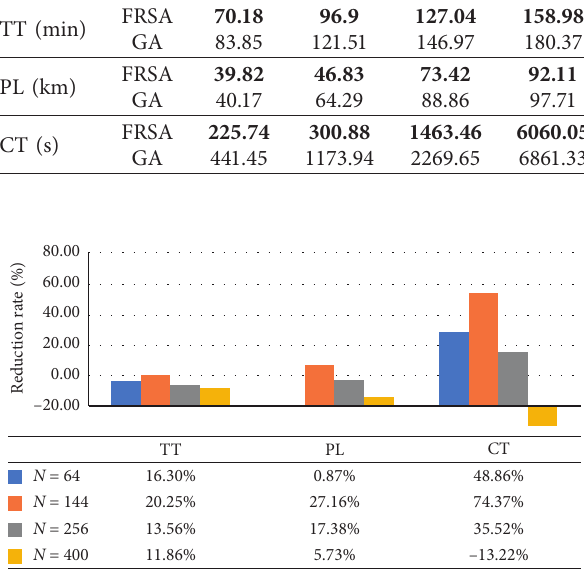
Figure 8: The reduction rate of the optimal paths offered by FRSA compared with GA in terms of TT, PL, and